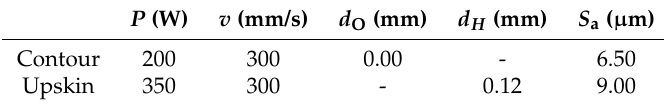
Table 10. Optimized factor levels for SLM-made surfaces.